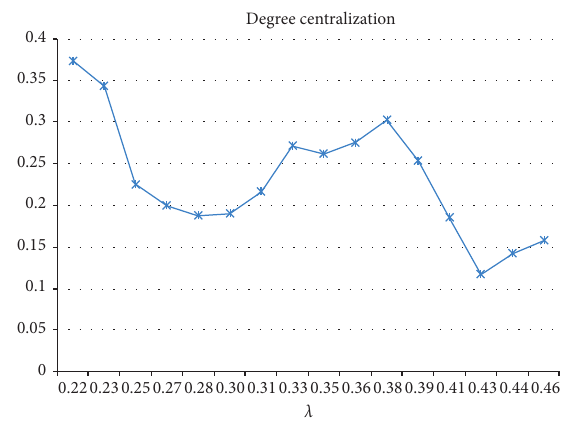
Figure 9: Effect diagram of degree centralization after threshold λ is